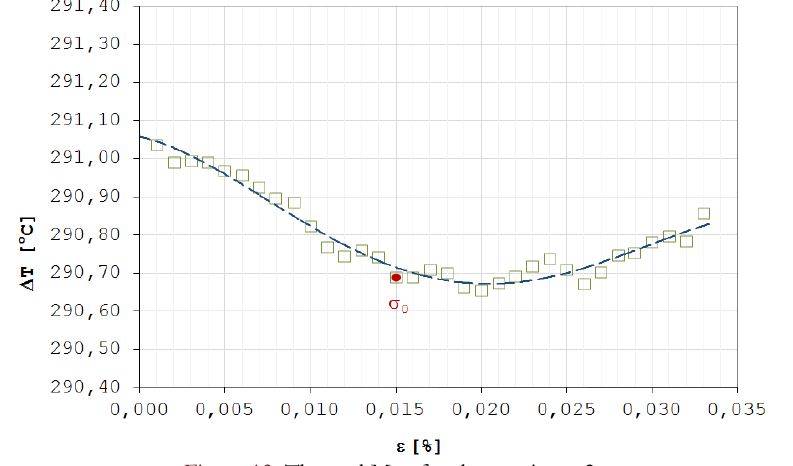
Figure 13: Thermal Map for the specimen